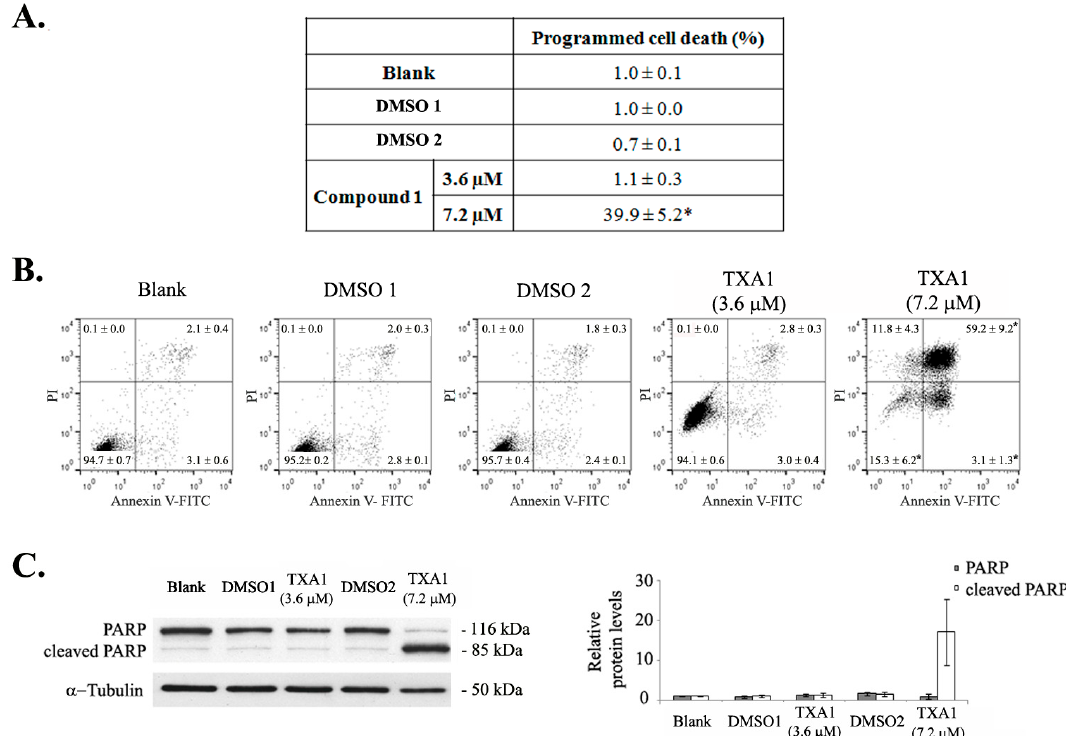
Figure 2. The effect of TXA1 on cell death by apoptosis of A373-C5 cells. Cells were treated for 48 h with medium (blank), TXA1 (3.6 μ M and 7.2 μ M), or with the corresponding DMSO concentrations (DMSO 1 and DMSO 2, respectively). ( A ) Levels of programmed cell death were analyzed with the TUNEL assay. Etoposide (1 μ M) was used as a positive control (4% ± 0.1% of programmed cell death). * p < 0.05 Blank vs. treatment ( B ) Flow cytometry analysis of apoptotic cell death following Annexin V-FITC/PI staining. Images are representative of three independent experiments (values correspond to the mean ± SEM). Etoposide (1 μ M) was used as positive control (18% ± 1.4% apoptosis); ( C ) PARP levels were analyzed by Western blot. Image is representative of 4 independent experiments (left panel). Densitometry analysis of the Western blots is expressed after normalization of the values obtained for each protein with the values obtained for tubulin (in relation to blank cells) and represent the mean ± SEM from four independent experiments (right panel).